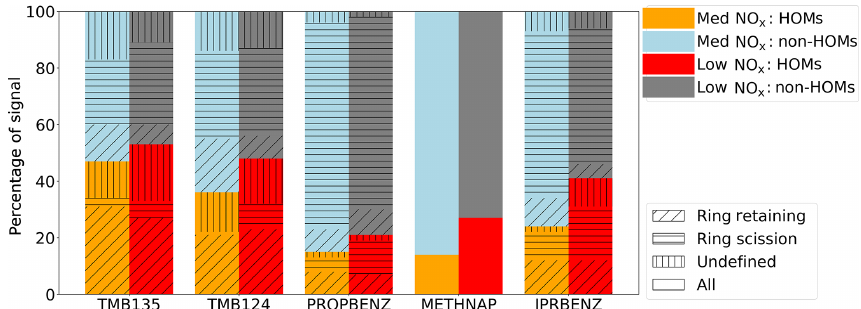
Figure 7. Contribution to I-CIMS product signal from HOM and non-HOM ions under low- and medium-NO x conditions. The hatched and shaded areas are grouped by ring retaining, scission and those for which we have no definition; the derivation of these classifications will be discussed in Sect. 4.2. Methylnaphthalene is split by HOM and non-HOM classifications only.